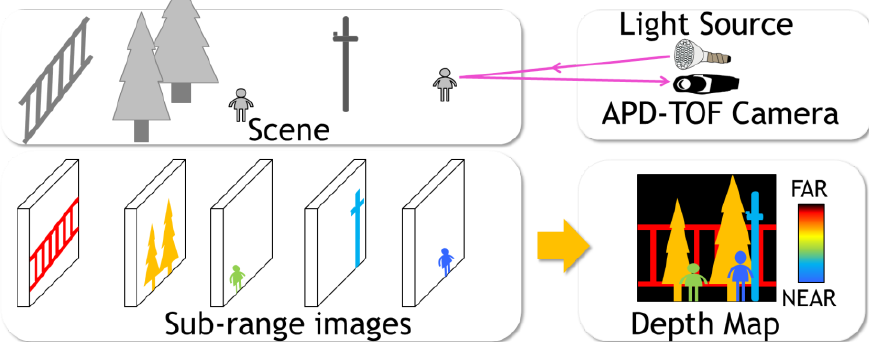
Figure 8. Principle of depth map construction in one frame out of plural five subrange images. Closer subrange images are colored by blue while the farther ones are colored by red.